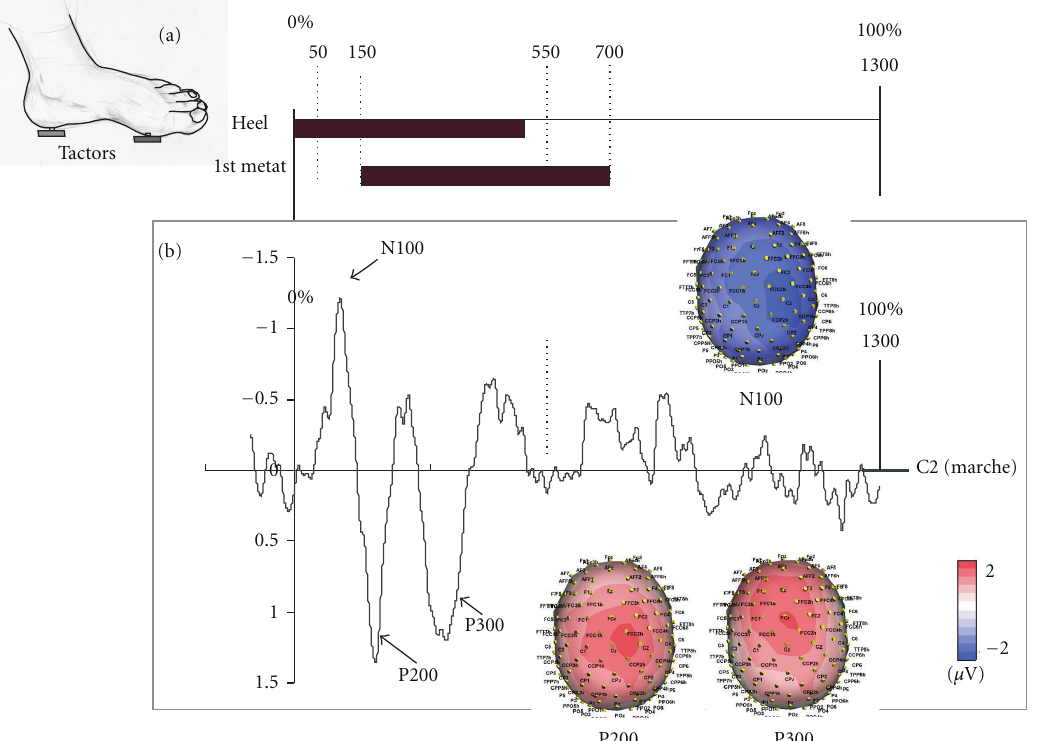
Figure 8: Vibrotactile stimulation. (a) The time profile of the vibrotactile stimulation provided by heel and first metatarsal tactors is shown. The timing and the duration of vibration correspond to a gait cycle at 3km/h speed [50]. (b) The evoked potential showing 3 main components (N100, P200, and P300) recorded at C2 electrode. The color maps show the distribution of these 3 evoked components. The C-2 Tactor is a linear actuator that has been optimized for use against the skin. The C-2 Tactor incorporates a moving “contactor” that is lightly preloaded against the skin. When an electrical signal is applied, the “contactor” oscillates perpendicular to the skin, while the surrounding skin area is “shielded” with a passive housing. Thus, unlike most vibrational transducers (such as common eccentric mass motors that simply shake the entire device), the C-2 provides a strong, point-like sensation that is easily felt and localized. For optimum vibrotactile e ffi ciency, the C-2 is designed with a primary resonance in the 200–300 Hz range that coincides with peak sensitivity of the Pacinian corpuscle, the skin’s mechanoreceptors that sense vibration. The subjects are seated with both feet on the floor, wearing a sandal on the left foot with a first tactor at the level of the heel and a second tactor at the level of the head of the first metatarsal. The stimulation of each tactor is made at a frequency of 300